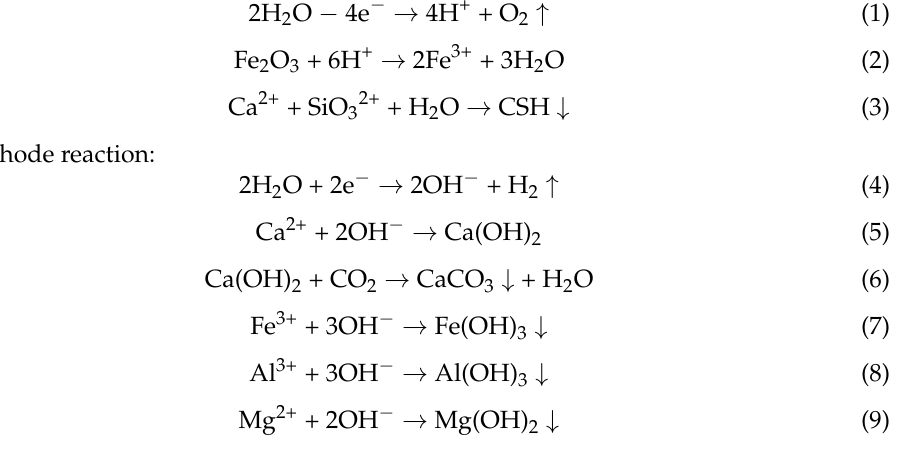
Table 3. Variability of water